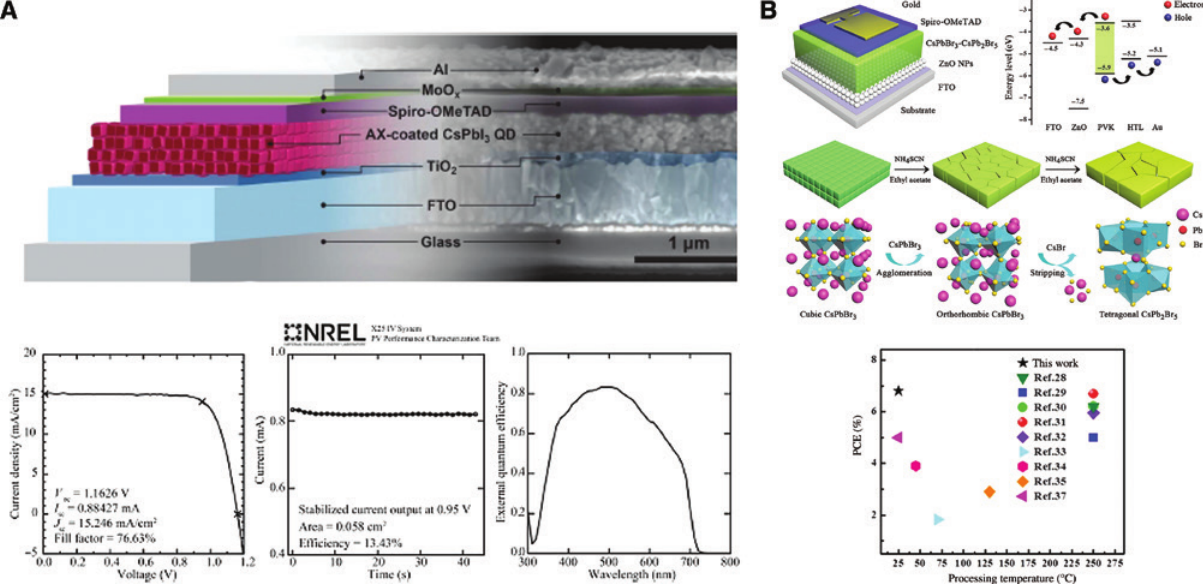
quantum dot sensitized solar cell, IV, and external quantum efficiency 3